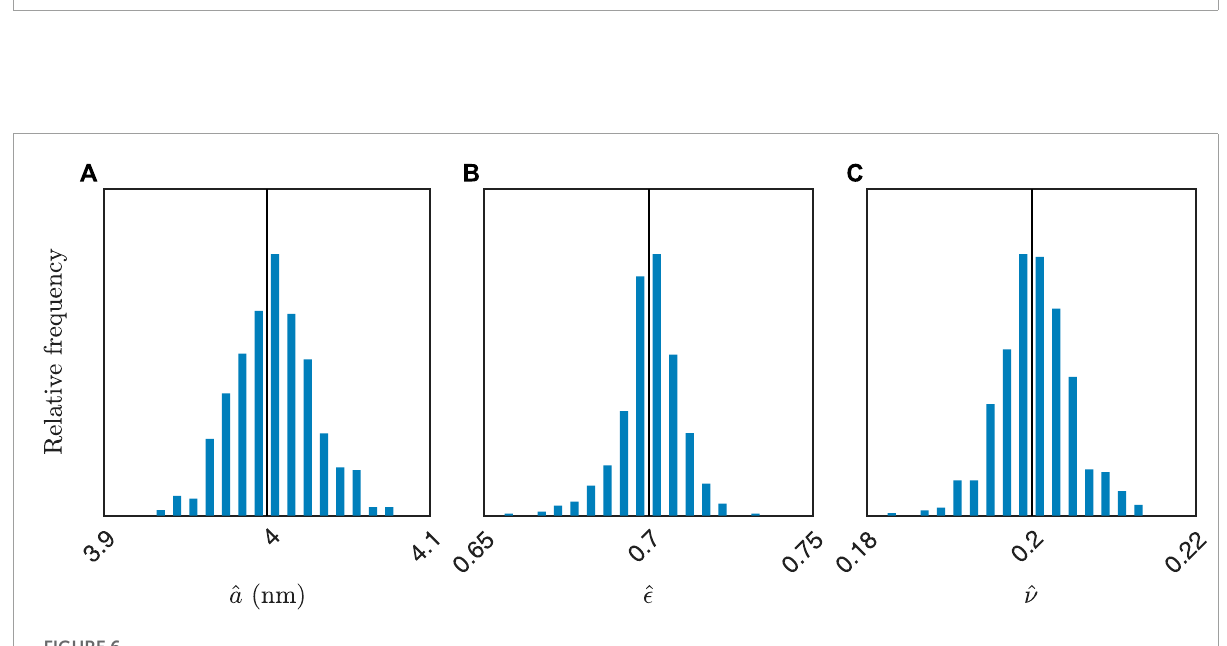
FIGURE 6 Histogram of estimated values for 500 simulated SAXS curves for a = 4 nm, ϵ = 0.70, and ν = 0.20. In (A–C) , the distribution of estimated values of a , ϵ , and ν are shown. The true values are also indicated (vertical black